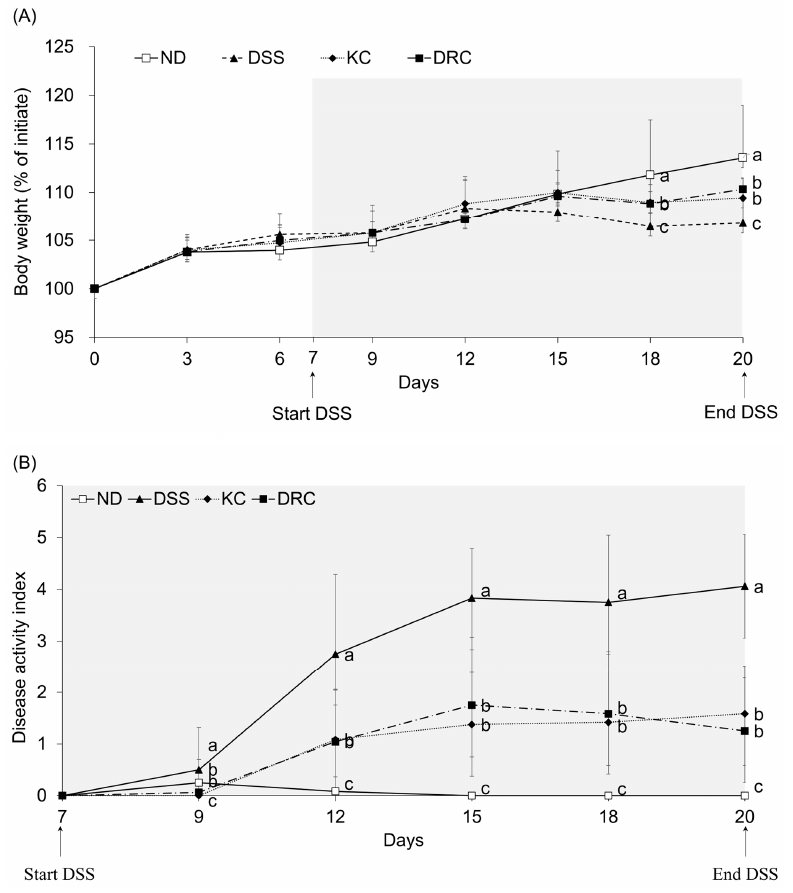
Figure 2. Effects of kimchi and Leu. mesenteroides DRC 1506 on changes of body weight ( A ) and disease activity index (DAI) ( B ) during DSS treatment. ( A ) The body weight was measured daily at the same time as the start of the experiment, and ( B ) DAI was evaluated every day after starting DSS drinking. Comparisons among groups were evaluated using one-way ANOVA with Duncan’s post hoc test. Groups with different letters had a significant difference at p < 0.05. ND, normal group; DSS, DSS-treated group; KC, DSS + 1 × 10 9 CFU/day/mouse of kimchi group; DRC, DSS + 1 × 10 9 CFU/day/mouse of Leu. mesenteroides DRC 1506 isolated from kimchi. The colon length of the DSS group was significantly reduced compared with the ND group, confirming that the colon tissue was damaged (Figure 3A,B). The KC and DRC groups not only showed significantly higher colon lengths compared with the DSS group, but lengths similar to those of the ND group. The weight per colon length was